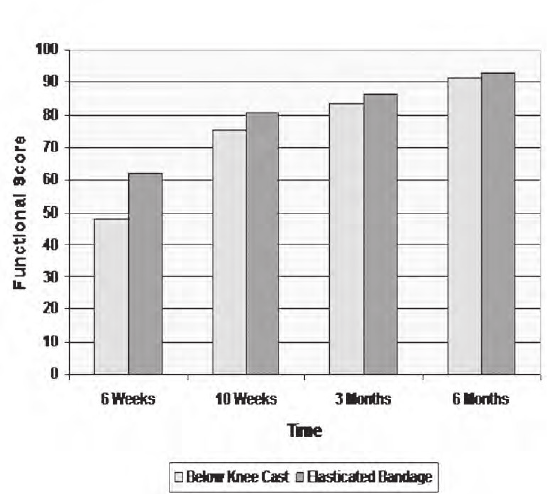
Figure 1: Mean Functional Score according to Olerud & Molander Similarly, visual analogue pain score (Figure 2) recorded (cid:71)(cid:88)(cid:85)(cid:76)(cid:81)(cid:74)(cid:3) (cid:90)(cid:72)(cid:76)(cid:74)(cid:75)(cid:87)(cid:3) (cid:69)(cid:72)(cid:68)(cid:85)(cid:76)(cid:81)(cid:74)(cid:3) (cid:90)(cid:68)(cid:86)(cid:3) (cid:68)(cid:79)(cid:86)(cid:82)(cid:3) (cid:86)(cid:76)(cid:74)(cid:81)(cid:76)(cid:191)(cid:70)(cid:68)(cid:81)(cid:87)(cid:79)(cid:92)(cid:3) (cid:76)(cid:80)(cid:83)(cid:85)(cid:82)(cid:89)(cid:72)(cid:71)(cid:3) in group B in comparison to group A in all follow ups. Immobilized group required less analgesic but the (cid:71)(cid:76)(cid:73)(cid:73)(cid:72)(cid:85)(cid:72)(cid:81)(cid:70)(cid:72)(cid:3)(cid:90)(cid:68)(cid:86)(cid:3)(cid:81)(cid:82)(cid:87)(cid:3)(cid:86)(cid:87)(cid:68)(cid:87)(cid:76)(cid:86)(cid:87)(cid:76)(cid:70)(cid:68)(cid:79)(cid:79)(cid:92)(cid:3)(cid:86)(cid:76)(cid:74)(cid:81)(cid:76)(cid:191)(cid:70)(cid:68)(cid:81)(cid:87)(cid:17)(cid:3)